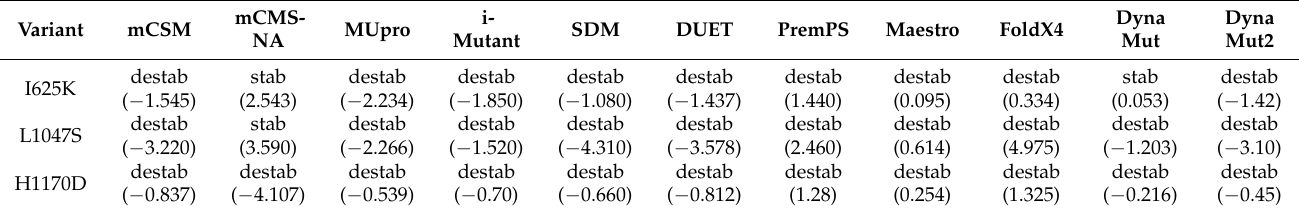
Table 1. Predicted stability changes ( ∆∆ G in kcal/mol) in DROSHA protein structure upon the selected mutations.